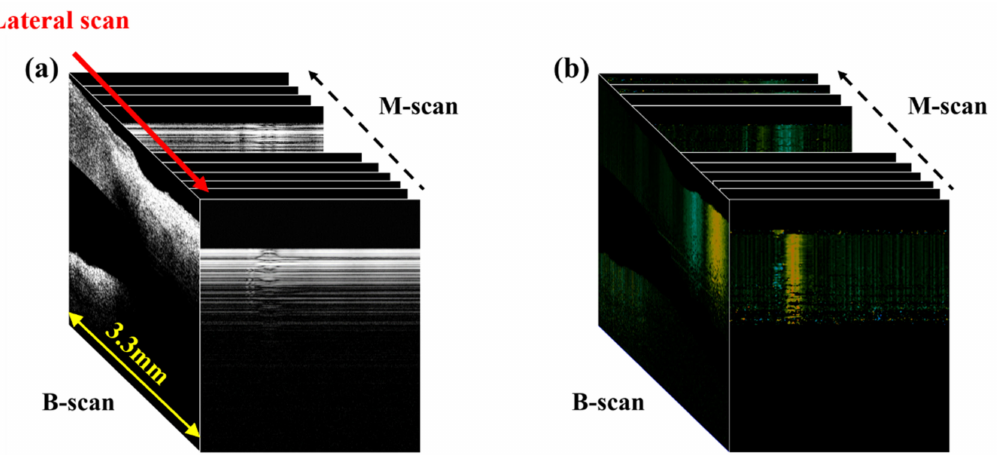
Figure 2. Schematic diagram of M-scan mode. ( a ) OCT images with the M-B mode scan protocol. ( b ) OCE images with the M-B mode scan